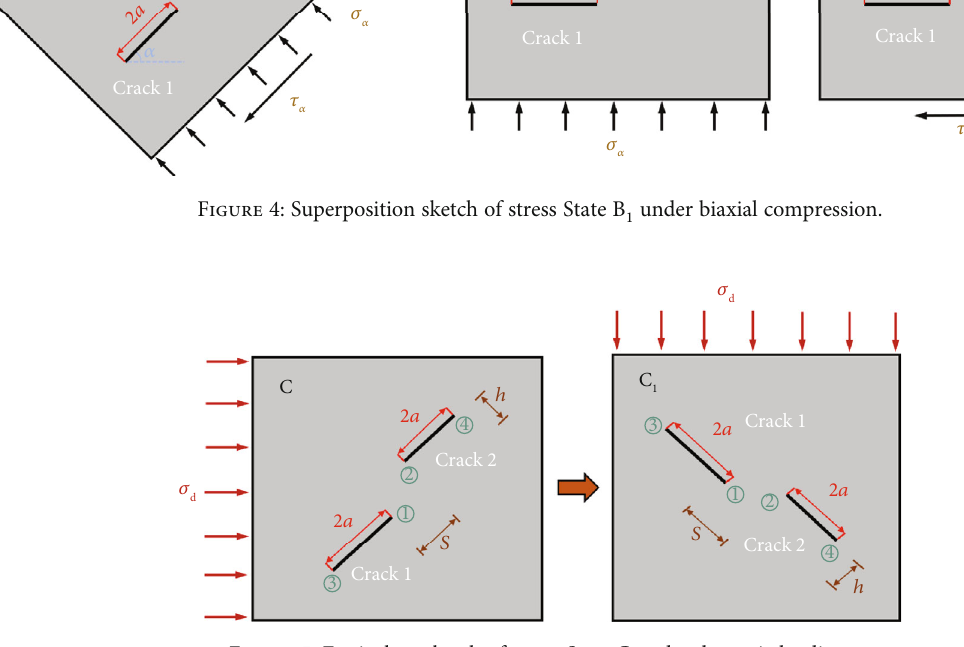
Figure 5: Equivalent sketch of stress State C under dynamic